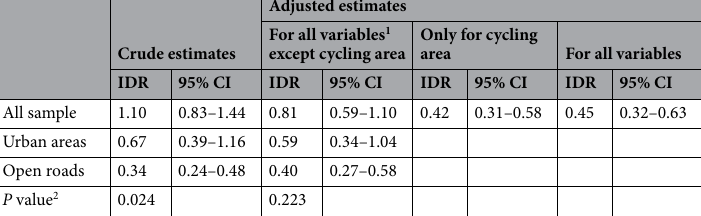
Table 2. Incidence–density ratio (IDR) estimates for the association between helmet use and death of cyclists, based on Poisson regression models. 1 Age, sex, nationality, commission of infractions, reason for cycling, type of crash, traffic lane characteristics, meteorological conditions, road surface, time of day, and year. 2 P value of the interaction term between cycling area and helmet